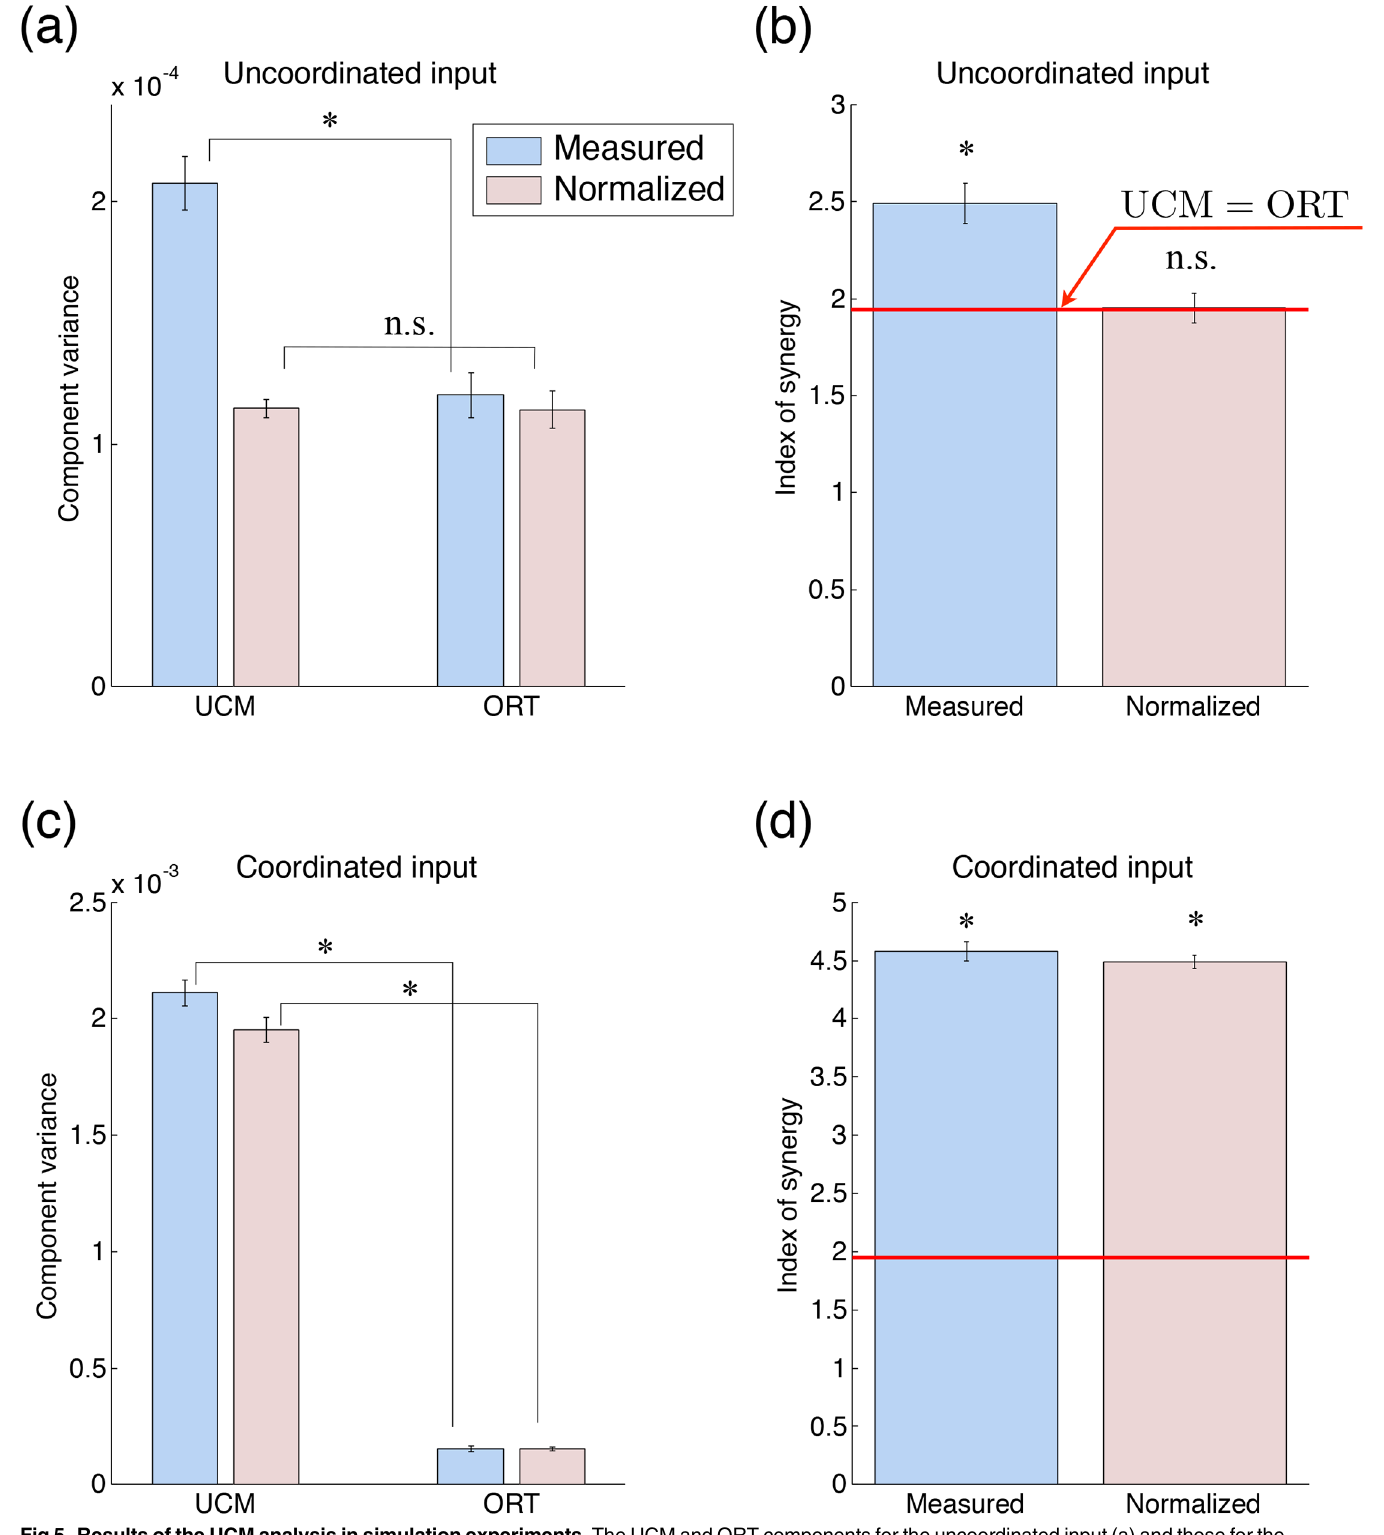
Fig 5. Results of the UCM analysis in simulation experiments. The UCM and ORT components for the uncoordinated input (a) and those for the coordinated input (c). The blue and red bars denote the component variance for the measured muscle tensions T i and that for the normalized muscle tensions